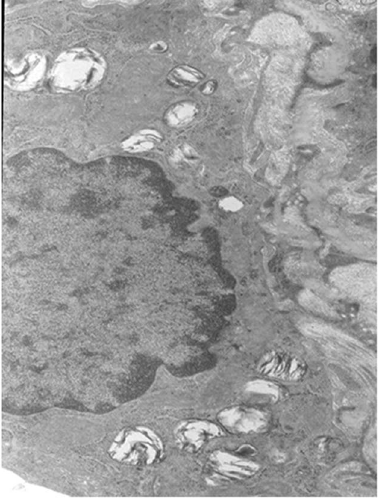
Figure 7. The Type II alveolar epithelial cells of the control group ( 6 8000). The Type II alveolar epithelial cells have a normal structure.